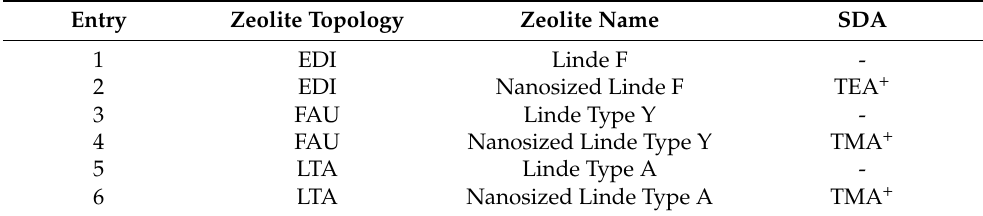
Table 2. Effects of organic SDAs on the particle size of zeolites